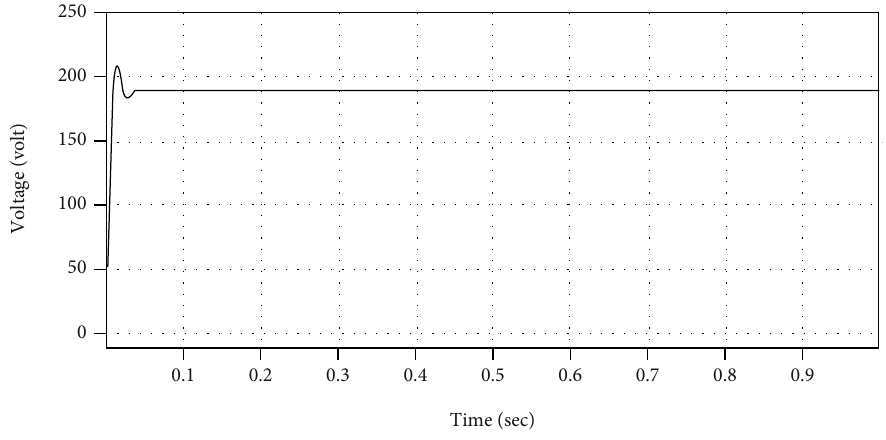
Figure 11: Output voltage waveform of conventional IBC on D = 0 : 7 .